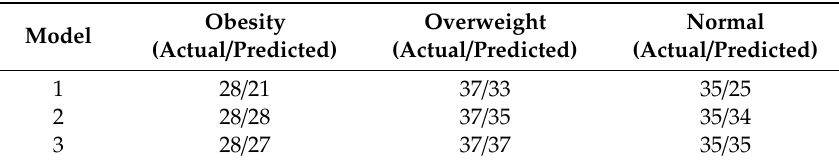
Table 7. The classification results of the models in the 250 KHz frequency